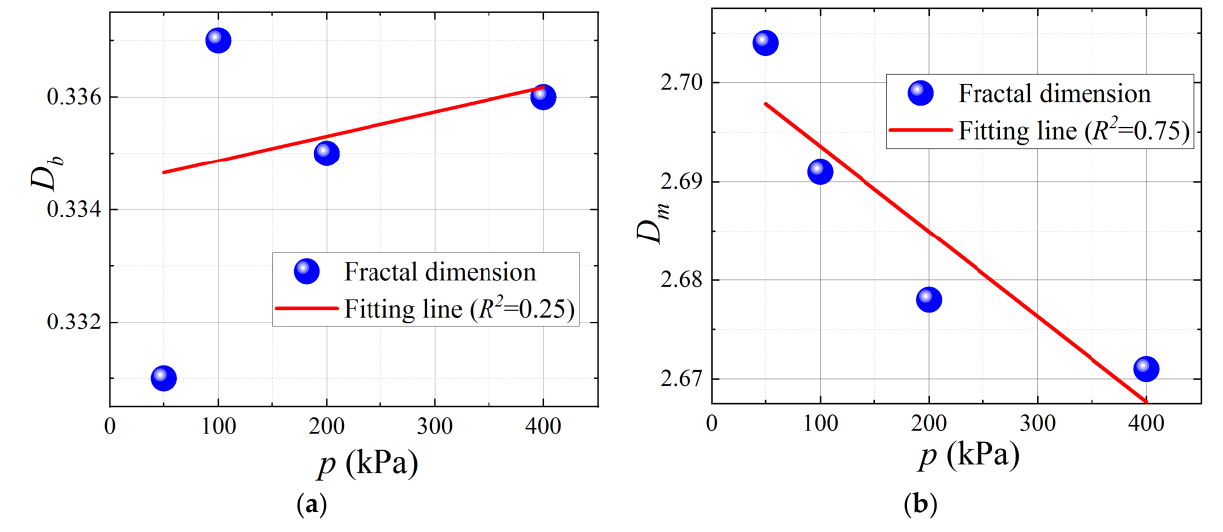
Figure 12. Fractal dimension under various freezing pressures: ( a ) fractal dimension for bound fluid; ( b ) fractal dimension for movable fluid.